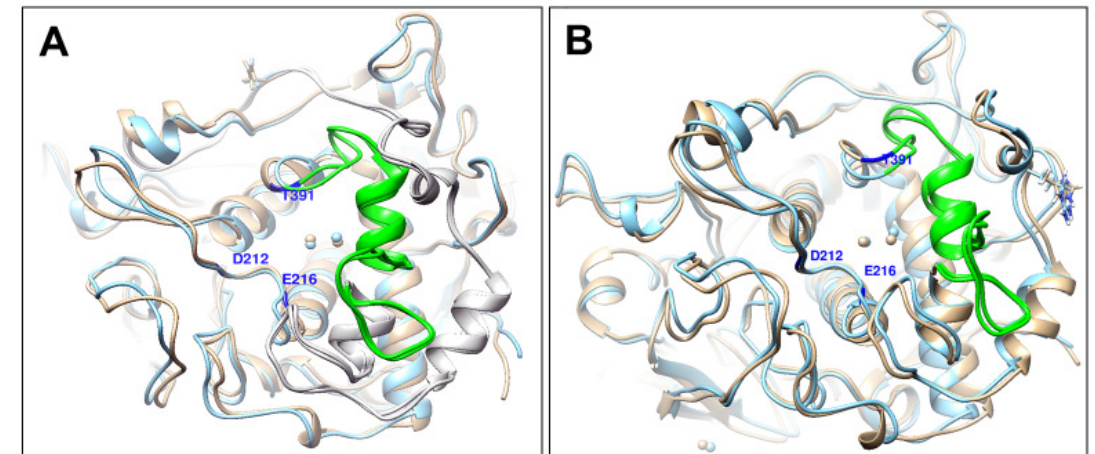
Figure 6. Changes in a mutant protein structure are caused by genetic perturbations. Mutant variants, D308N ( A ) and R326H ( B ), and Tyrp1 superposition demonstrates the changes in a whole mutant protein structure. Mutant protein and Table 1. ribbons are shown in blue and gold, respectively. The green part of the ribbon corresponds to residues 362–391.